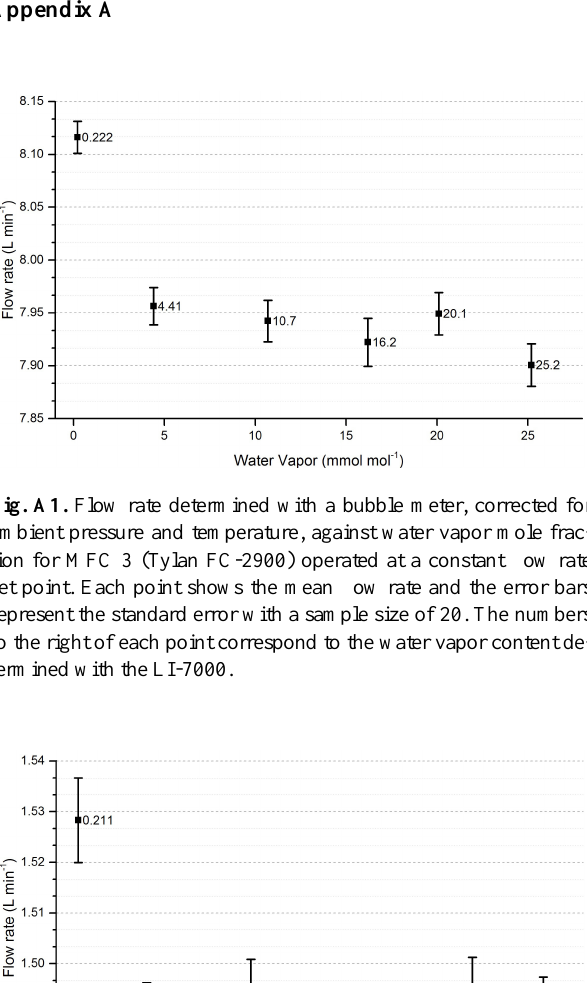
Table A1. Averaged loss of ozone signal at the three different